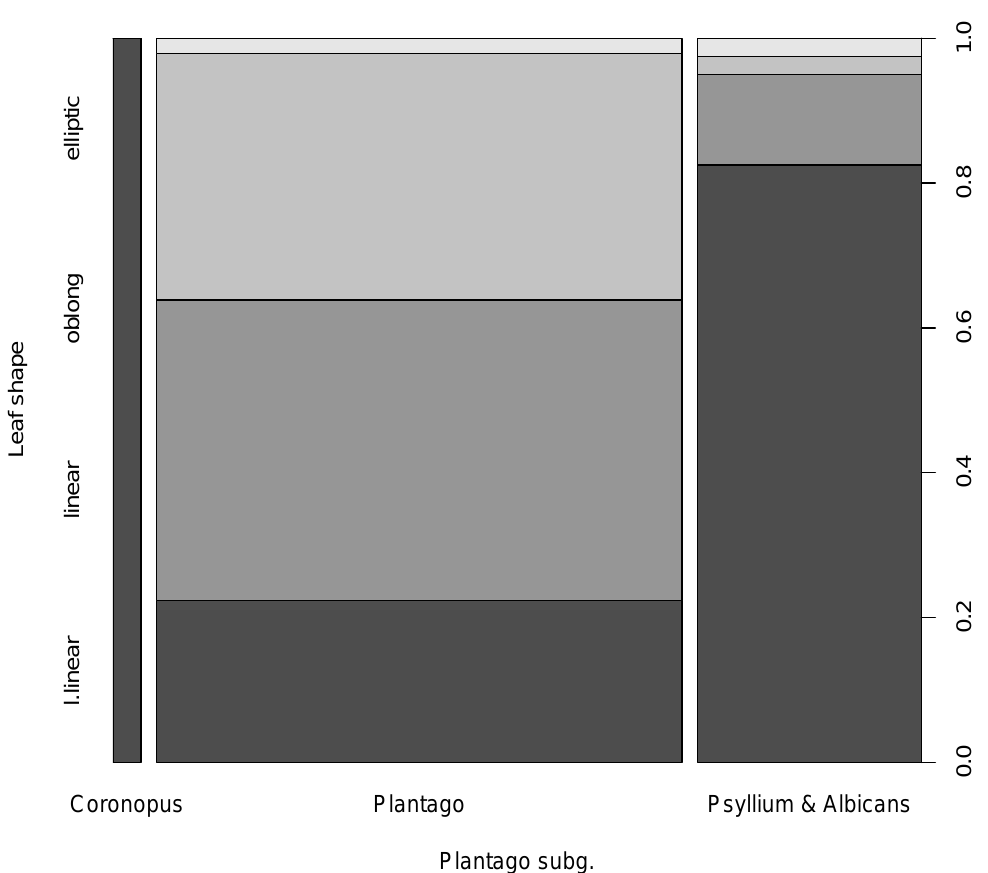
Figure 8. Plantago leaf shapes vs. Plantago subgenera. This plot derived from the cross-tabulation which uses a morphometric dataset for leaf shapes, and shows the proportion of different leaf shapes across three subgenera. Bar widths are proportional to the number of species in each subgenus. The shades of gray separate different character